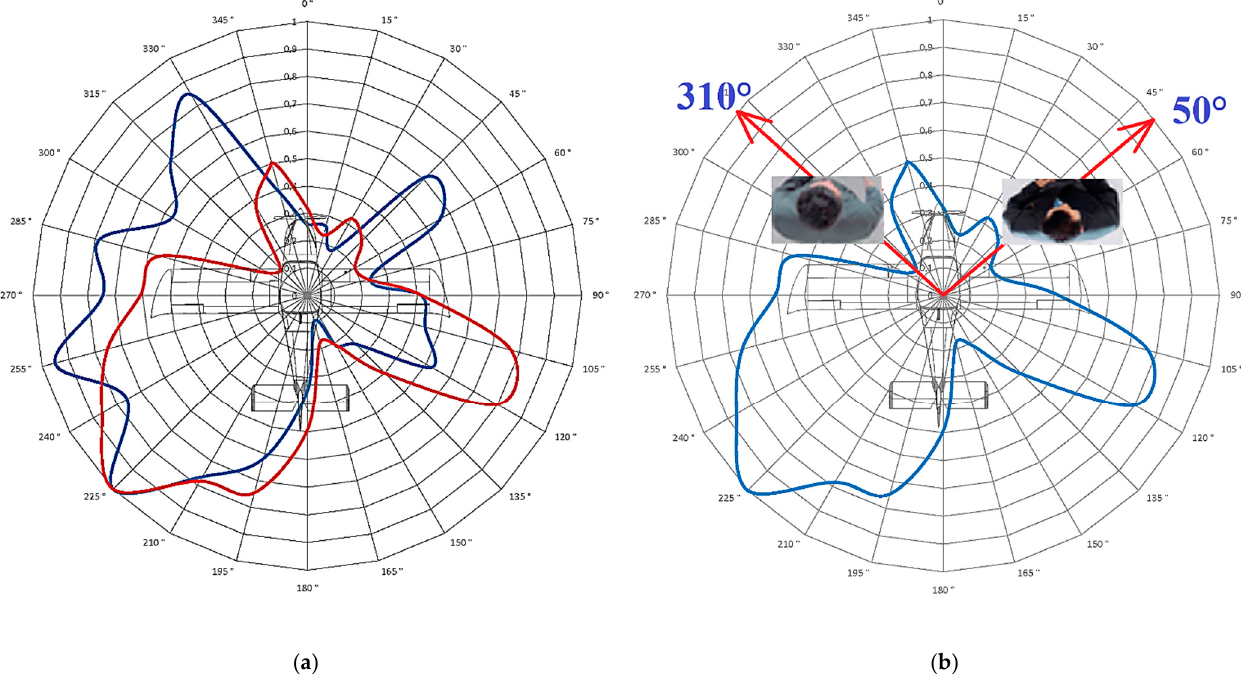
Figure 14. Influence of persons on the characteristic at an angle θ of 30° (blue curve indicates without crew, red curve indicates with crew): ( a ) comparison of measured characteristics; ( b ) influence of the position of persons on the shape of the characteristic.